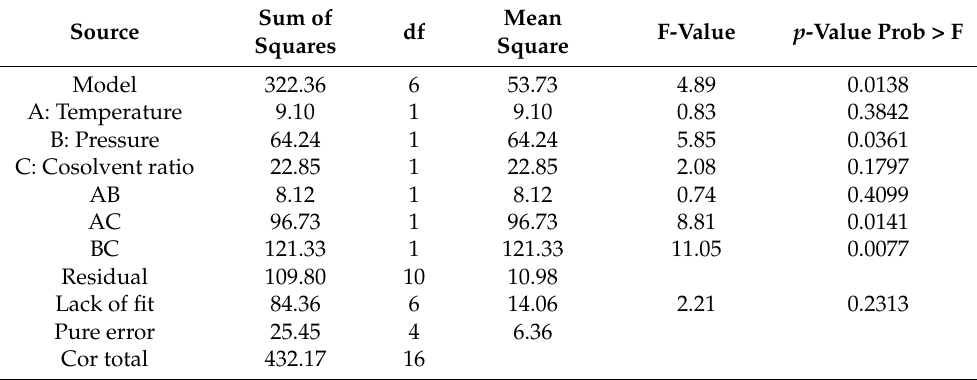
Table 2. ANOVA for response surface two-factors-interaction model for lipid recovery of M. alpina